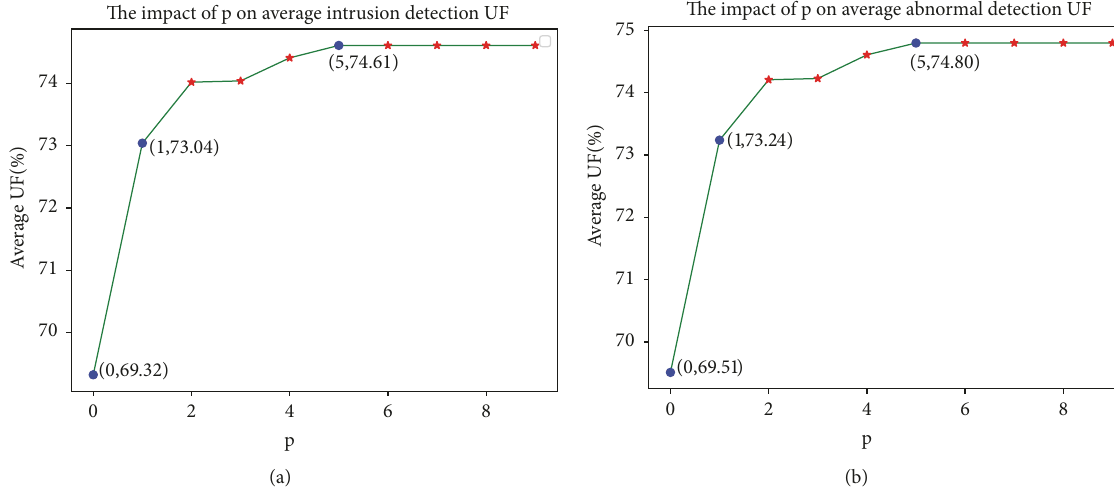
Figure 6: Effects of sliding window size p on the detection UF, where (a) is the impact of the value of p on the intrusion detection, which is measured as the utility function value. (b) is the effect on average abnormal detection UF value.